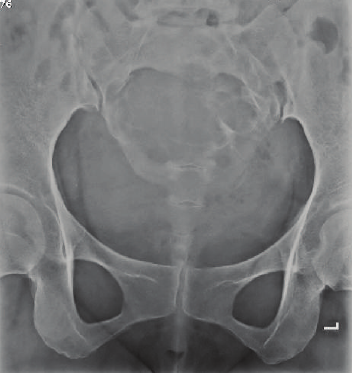
Figure 1: Plain radiograph shows osteolytic bony destruction at body of sacrum and bilateral neural